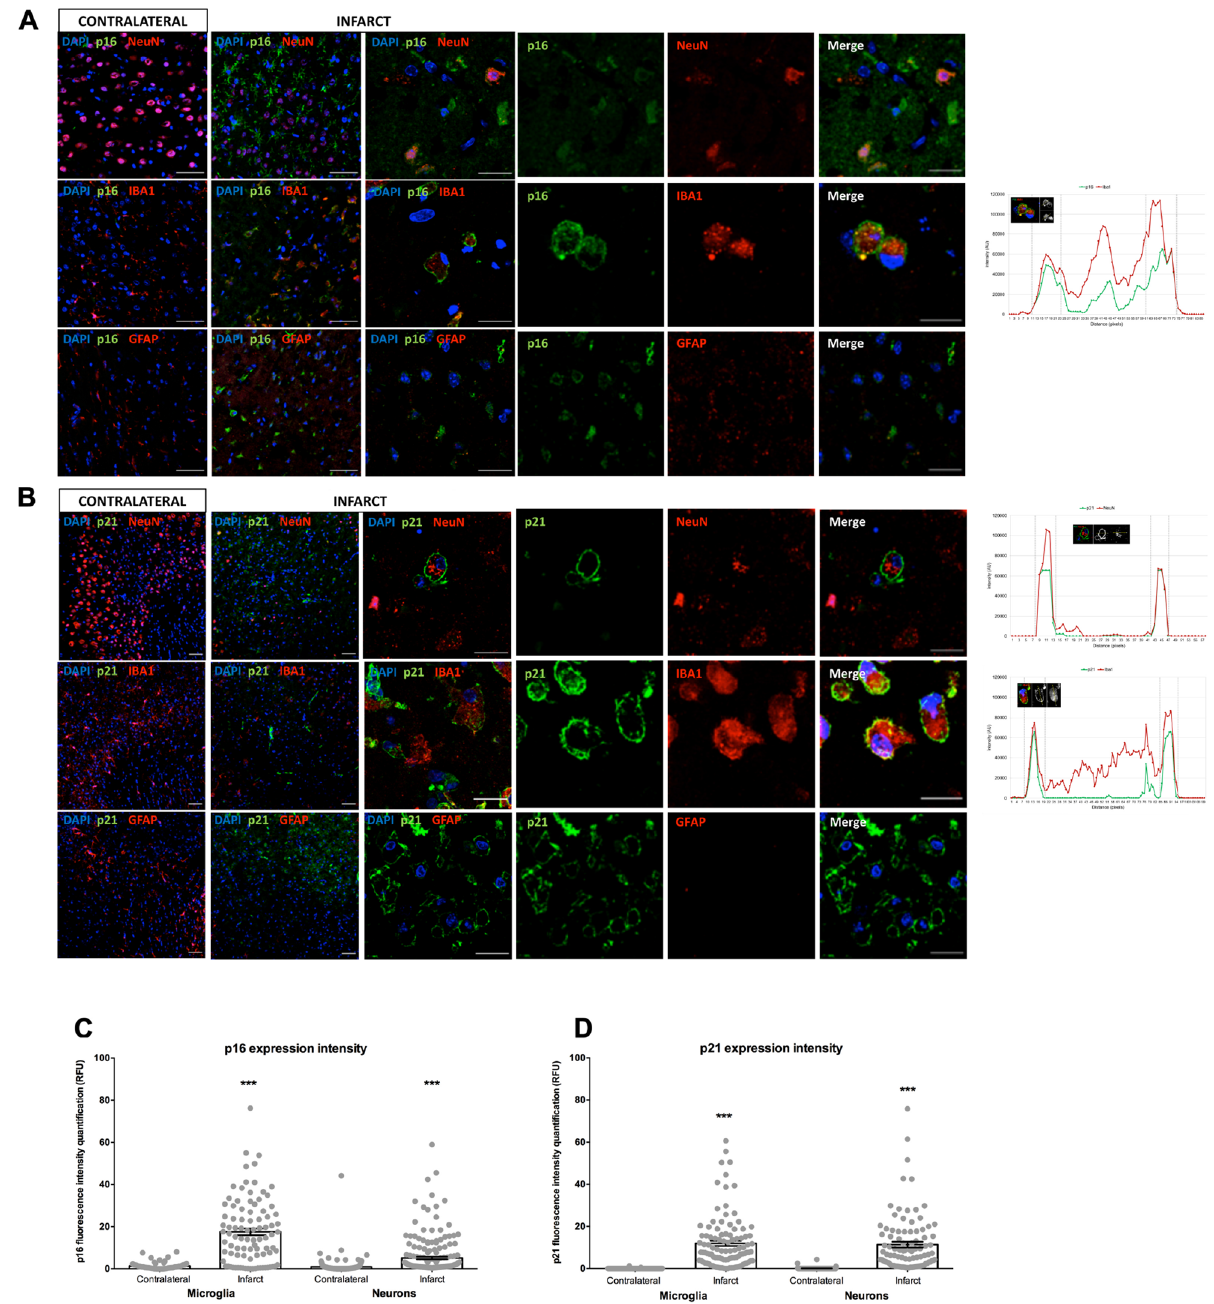
Figure 2. p16 and p21 subcellular location in a preclinical animal model of stroke. ( A ) Double immunofluorescence for co-localization of p16 (green), NeuN/IBA1/GFAP (red) and DAPI (blue). Intensity expression plot showed the cellular distribution of p16 in microglia. ( B ) Double immunofluorescence for co-localization of p21 (green), NeuN/IBA1/GFAP (red) and DAPI (blue). p16 and p21 immunostained cells could be observed in the infarct area at 3 days after tMCAO. Intensity expression plot showed the cellular distribution of p21 in microglia and neurons. ( C ) p16 expression intensity in microglia and neurons on contralateral and infarct areas. ( D ) p21 expression intensity in microglia and neurons on contralateral and infarct areas. Scale bar contralateral and infarct = 50 µm. Scale bar infarct zoom = 20